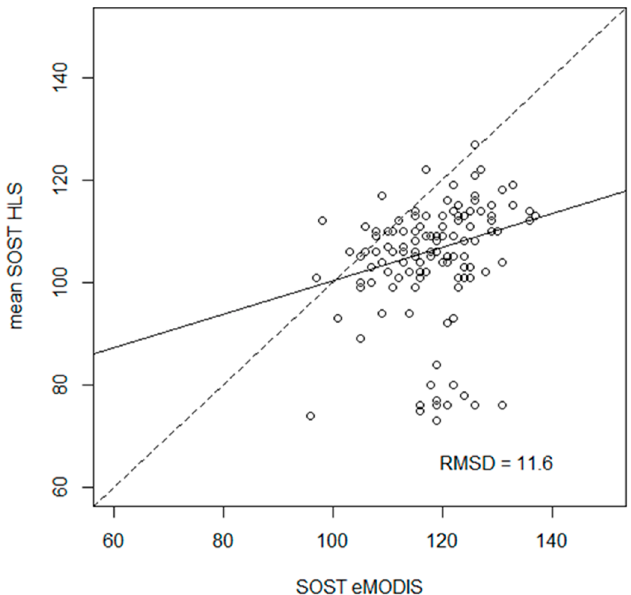
Figure 4. Relationship between eMODIS grassland SOST and mean SOST from corresponding cells in HLS data. RMSD represents the root mean squared difference [36]. The solid line shows the robust linear regression result (RMSD = 11.6). The dashed line is 1:1 line. Remote Sens. 2019 , 11 , x FOR PEER REVIEW